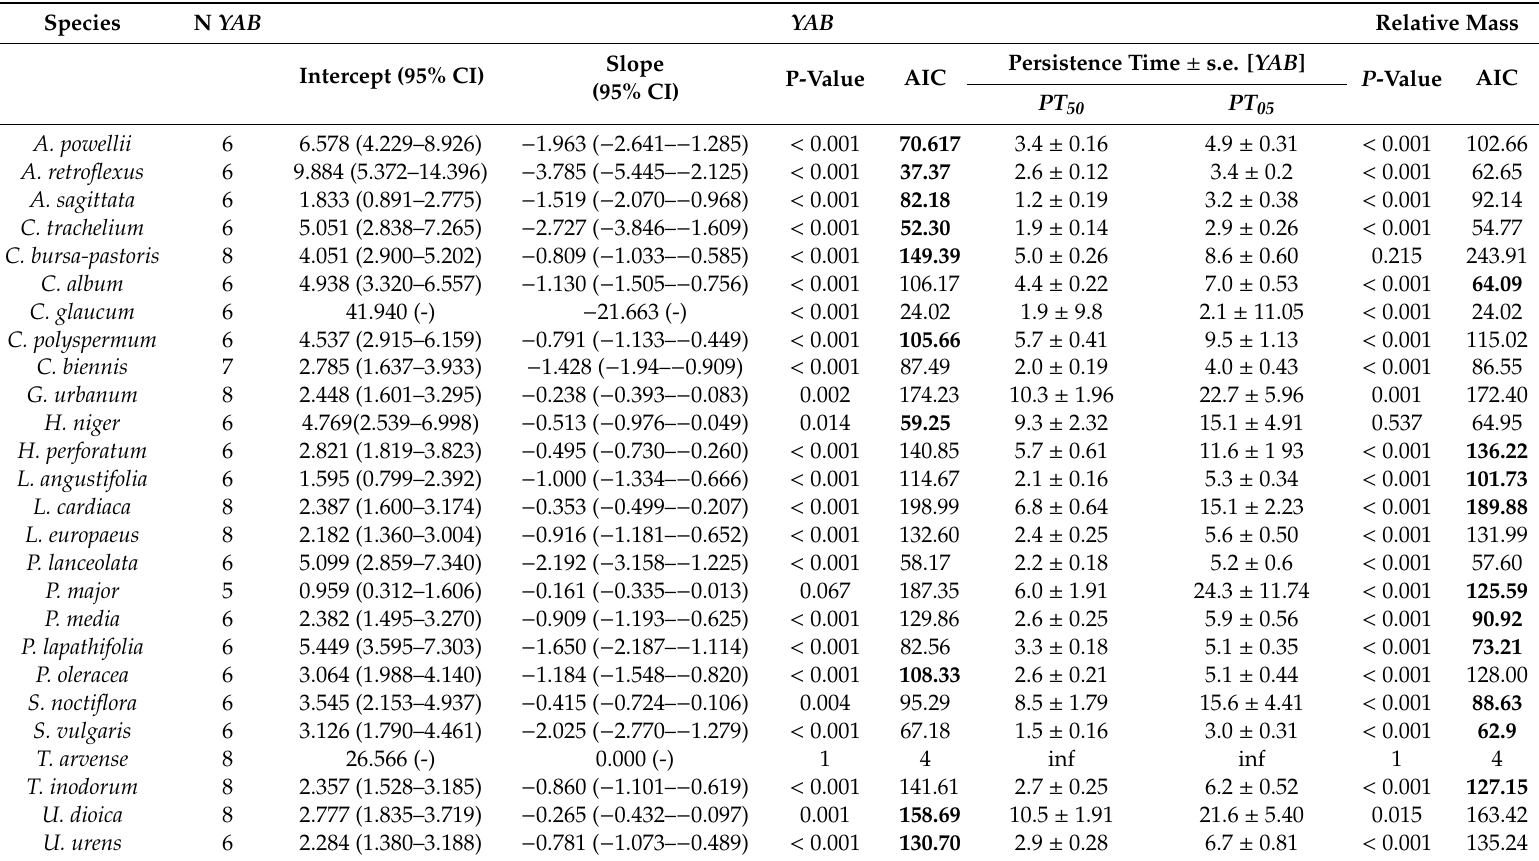
Table 2. Persistence of 26 species of seeds in soil as estimated by logistic regression based on the imbibed crush test (ICT). See Table 1 for the genus of plants. Year after burial ( YAB ) or seed mass relative to control seeds were used as explanatory variable based on 5–8 YAB cohorts (N YAB ). Intercept and slope are estimated parameters a and b , respectively, of the model: y = AIC—Akaike Information Criterion for the respective model. Significantly better models ( ∆ AIC > 2) are in bold. Persistence times PT 50 or PT 05 , accompanied with standard errors (s.e.), show the time in YAB when 50 or 5% of the initial cohort of seeds, respectively, were predicted to be still